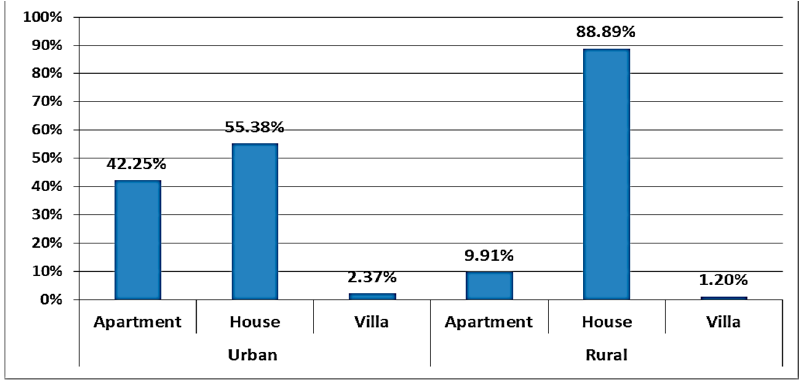
Figure 2. The percentage of households for urban and rural areas in Jordan in 2015.